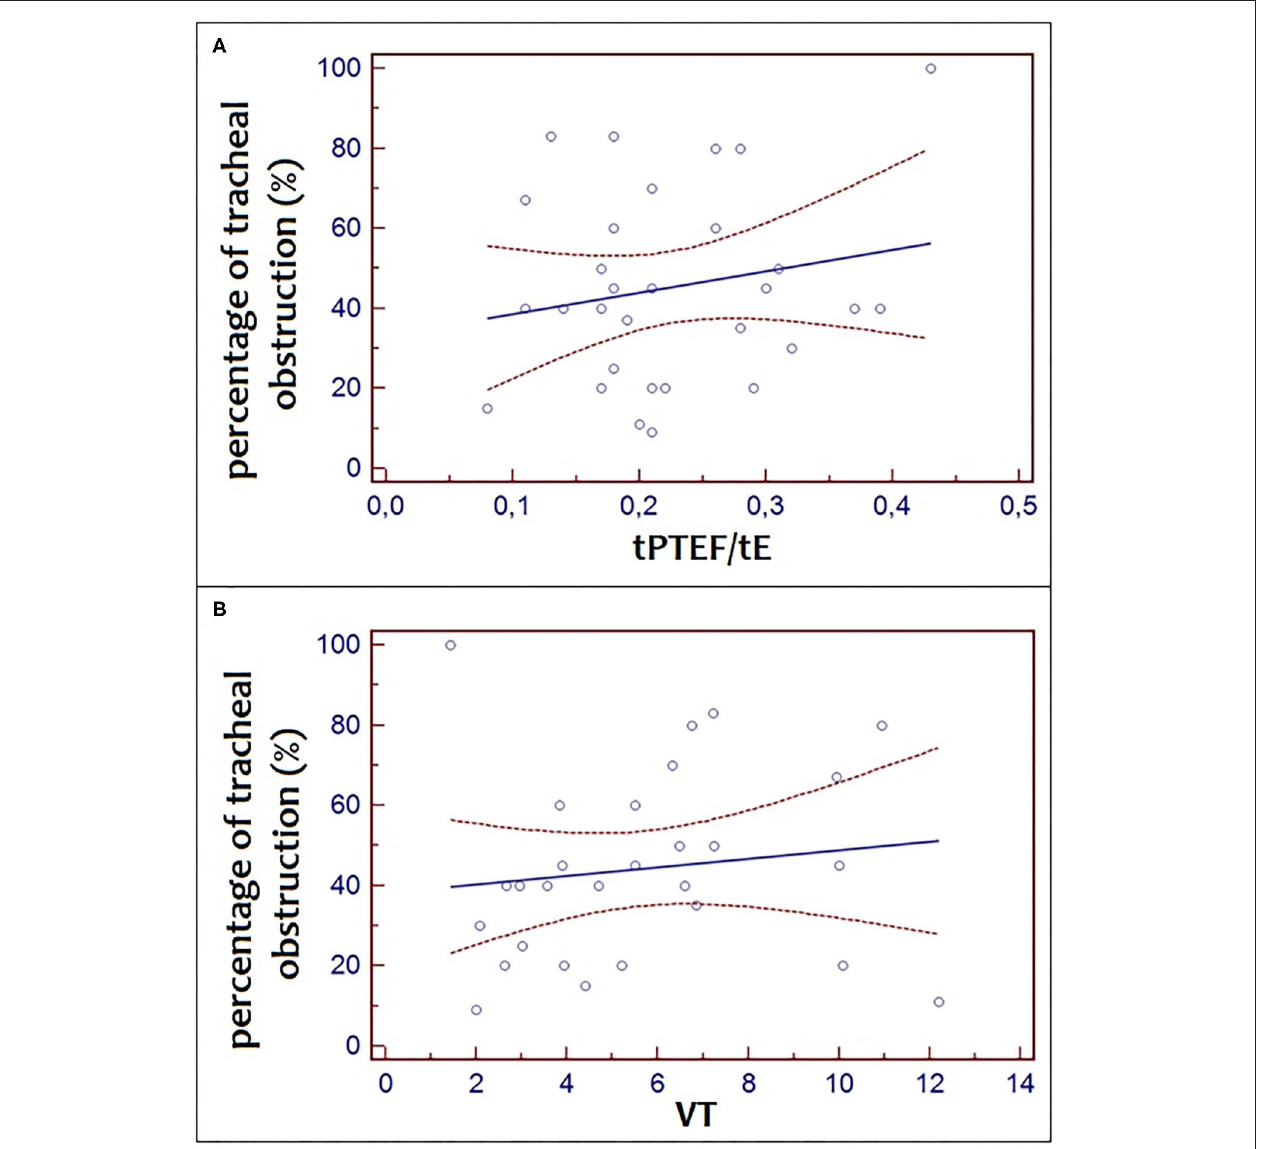
FIGURE 3 | Correlation between the percentage of tracheal obstruction and tPTEF/tE ( r 2 = 0.04, p = 0.32) and between the percentage of tracheal obstruction and VT ( r 2 = 0.06, p = 4 0.22).